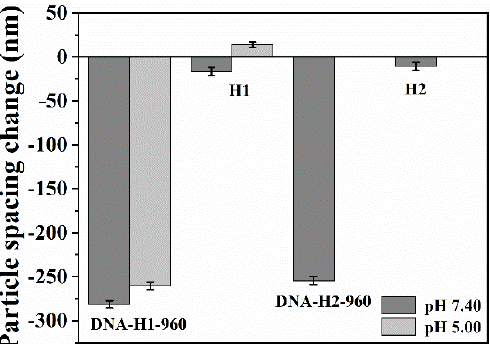
Figure 4. The particle spacing changes of various hydrogel films upon reaction with 500 μM lysozyme solutions. Compared with the hydrogels H1 and H2, the remarkable particle spacing decreases of the hydrogel sensors DNA − H1 − 960 and DNA − H2 − 960 with aptamers demonstrated the key actuation role of specific binding between the aptamer and lysozyme in the hydrogel shrinkage. Compared with DNA − H2 − 960 without N-tert-butyl groups, the larger particle spacing decrease of DNA − H1 − 960 showed the presence of the N-tert-butyl groups in the hydrogel network also facilitated the hydrogel shrinkage. The particle spacing change of DNA − H1 − 960 at pH 7.40 was larger than that at pH 5.00, showing the electrostatic interaction between carboxyl anions and lysozyme.